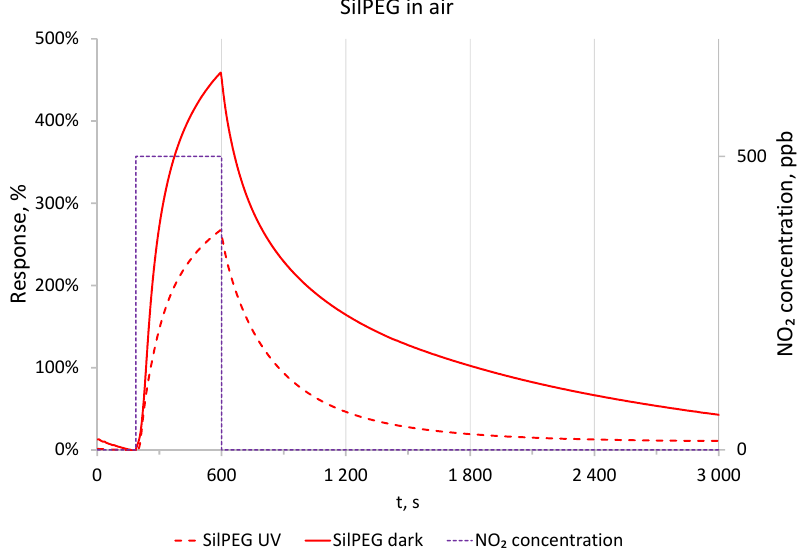
Figure 4. Comparison of responses to 500 ppb of NO 2 in dark conditions and with UV in air at RT.